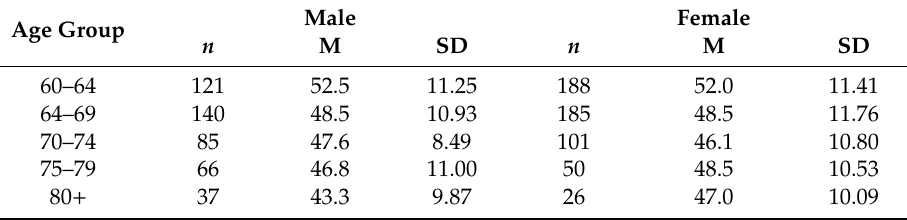
Table 3. Weight based on age group and gender, Unit: kg.